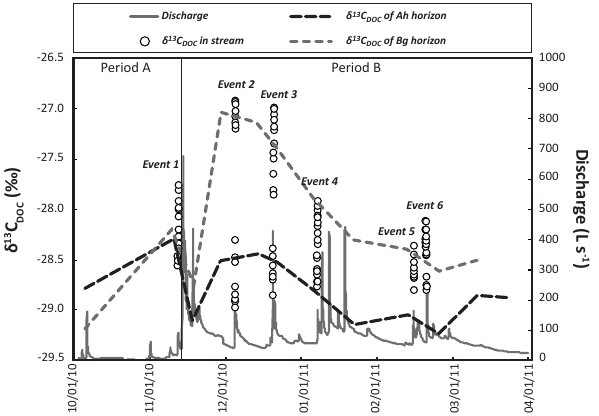
Figure 8. Comparison between storm-flow DOC isotopic data and the seasonal DOC isotopic trend observed in riparian soil waters at the Mercy site. Riparian soil water data are from Lambert et al. (2013).